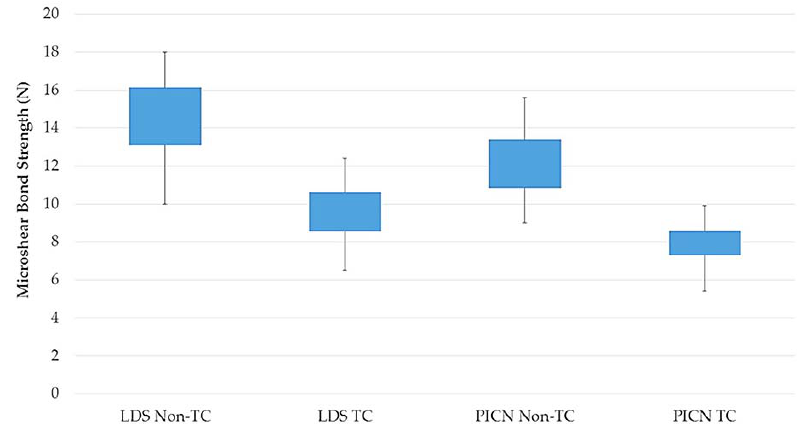
Figure 3. Box plot of flexural strength for each group.